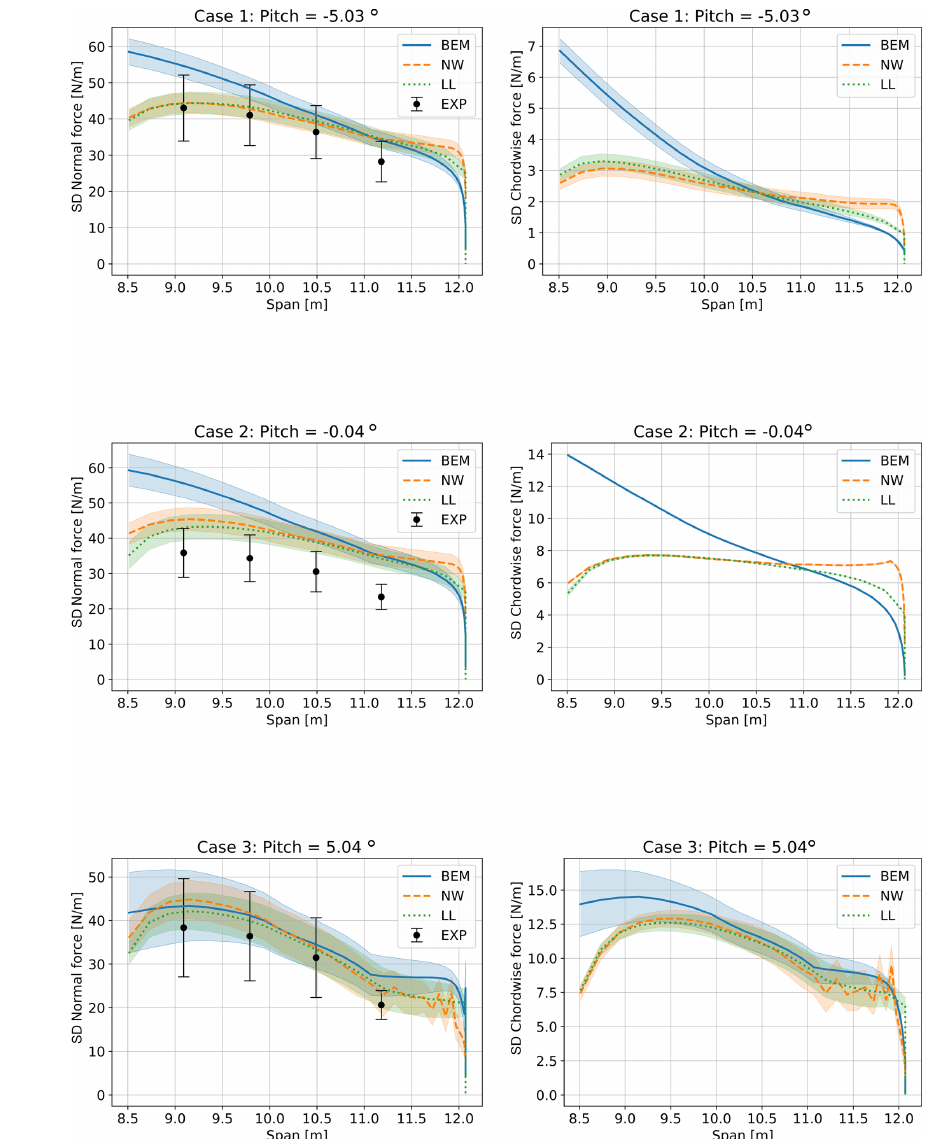
Figure 18. Comparison of standard deviations of normal force from turbulent simulations and the experiment. Results shown are averaged from four turbulent seeds per pitch angle, using the mean operating conditions as shown in Table 3 up to a pitch angle of 5 ◦ The shaded areas show the standard deviation between the standard deviations of the four simulations per pitch angle, to indicate the variability due to turbulent